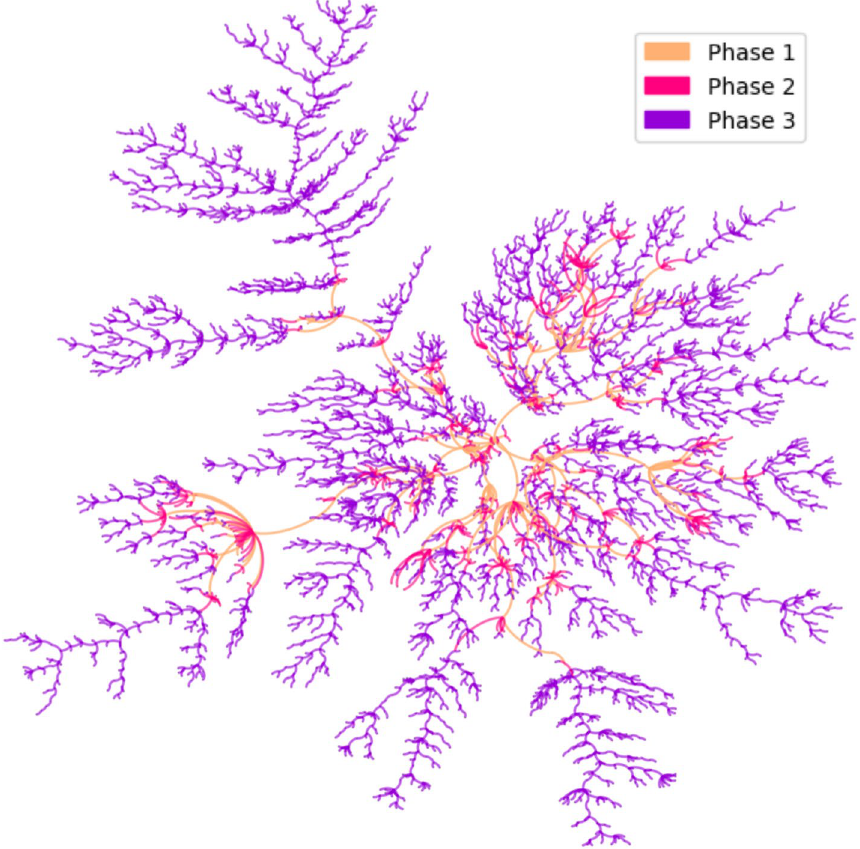
Figure 6. Minimum spanning tree: stages of COVID-19